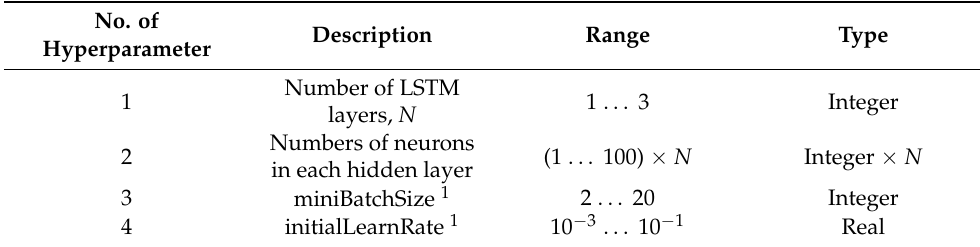
Table 1. Hyperparameters to be optimized using Bayesian optimization with predefined parameter